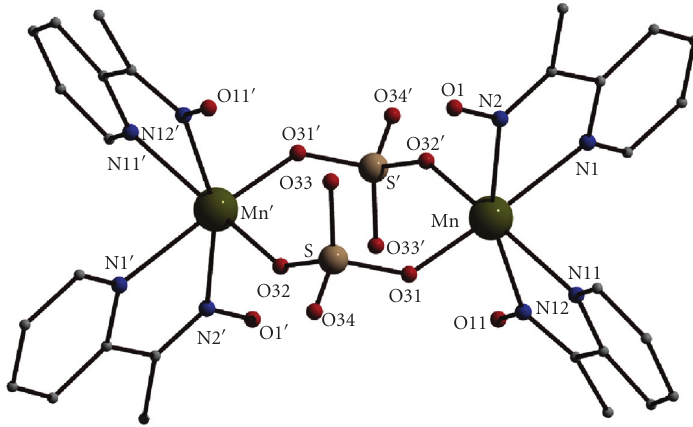
Figure 1: The dinuclear molecule present in 1 · (py)C(Me)NOH. Primes are used for the symmetry-related atoms.